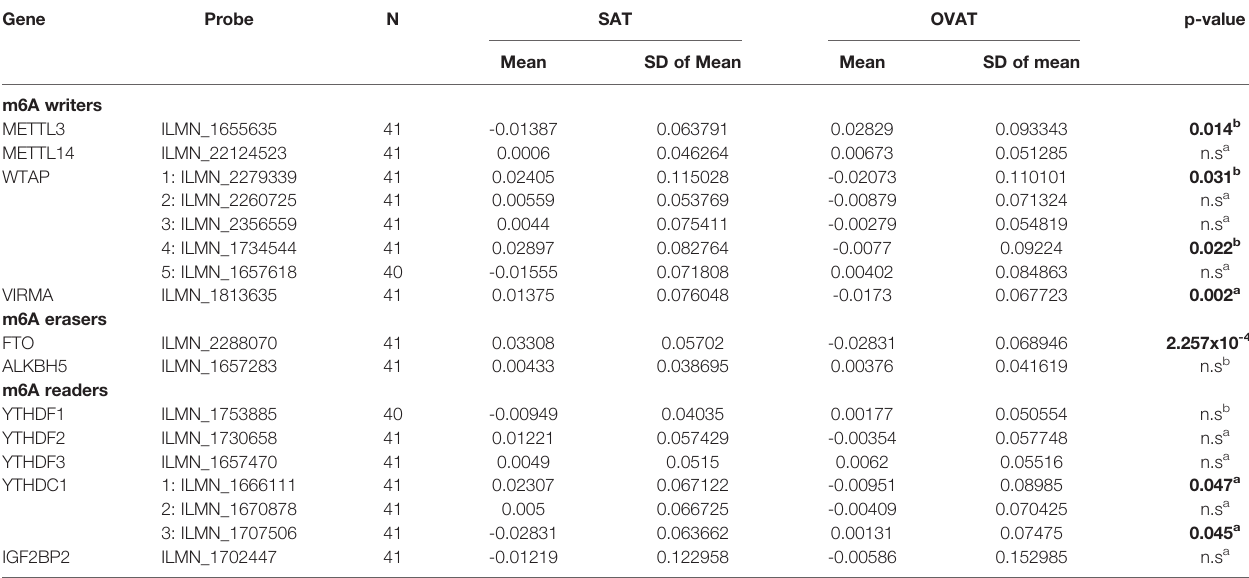
TABLE 3 | Differential gene expression of m6A regulators between SAT and OVAT.